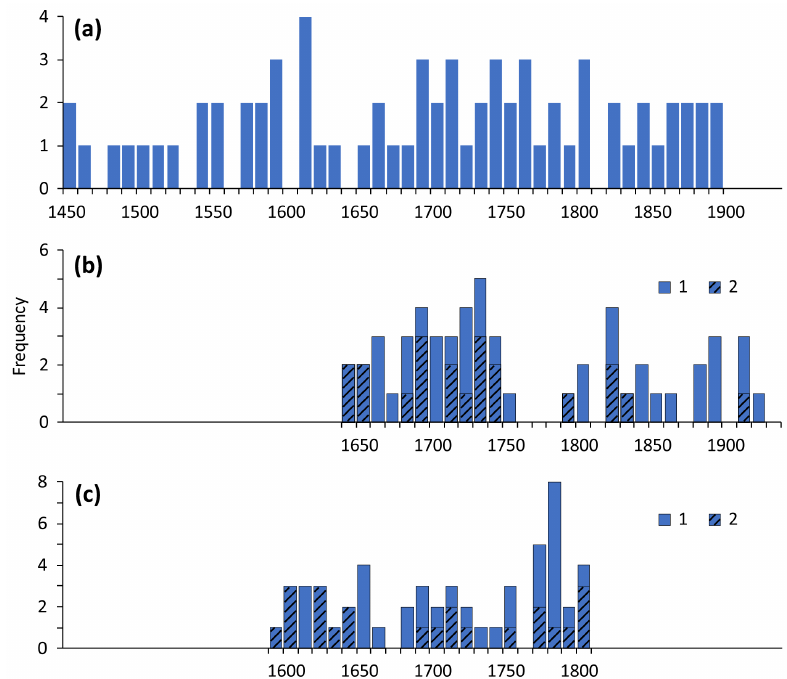
Figure 12. Long-term fluctuations in a range of documentary-based drought series across North and Central America: (a) decadal frequencies of droughts in central Mexico, 1450–1900 (Mendoza et al., 2005a); (b) decadal frequencies of droughts (1 – dry; 2 – very dry) of the Pacific coast of Central America, 1640–1945 (Guevara-Murua et al., 2018); (c) decadal frequencies of droughts (1 – dry; 2 – very dry) for Potosí, Bolivian Altiplano, Bolivia, 1585–1815 (Gioda and Prieto,